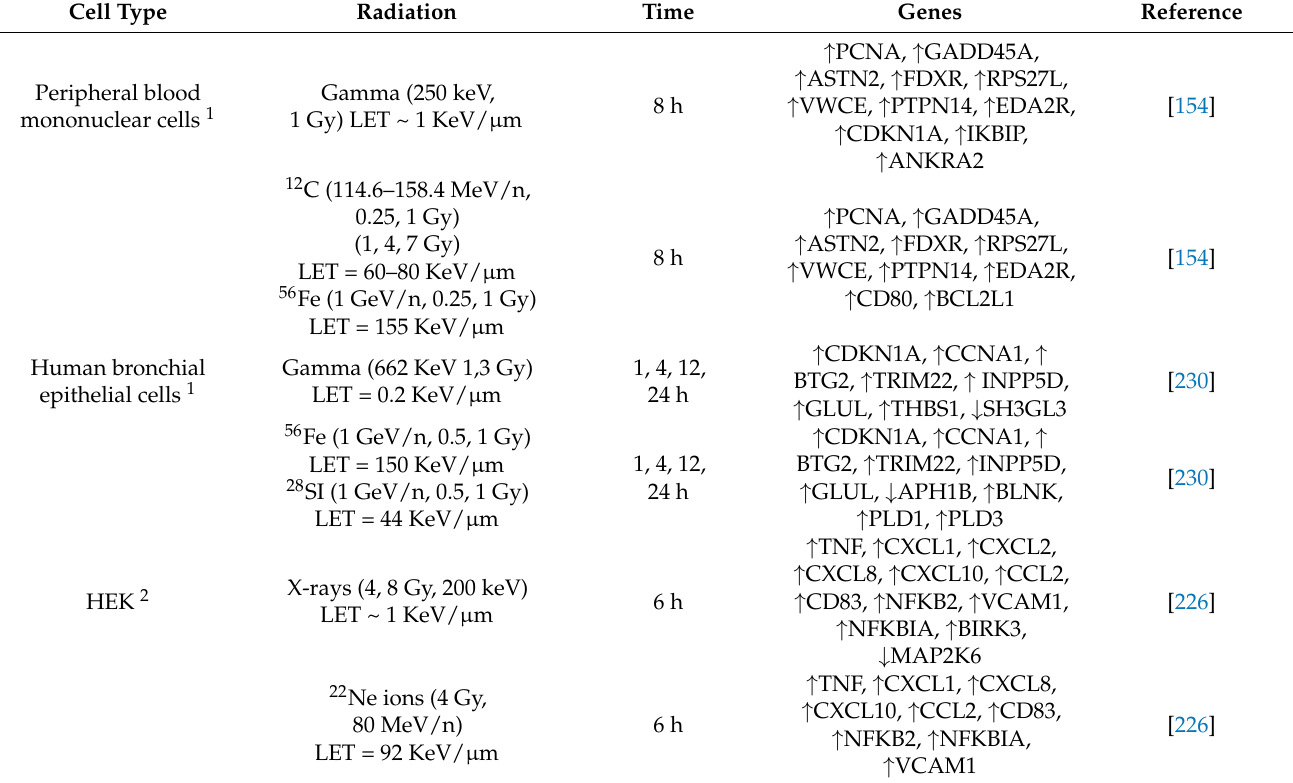
Table 6. Comparison of gene expression in normal cells after low- or high-LET radiation. Cell Type Radiation Time Genes